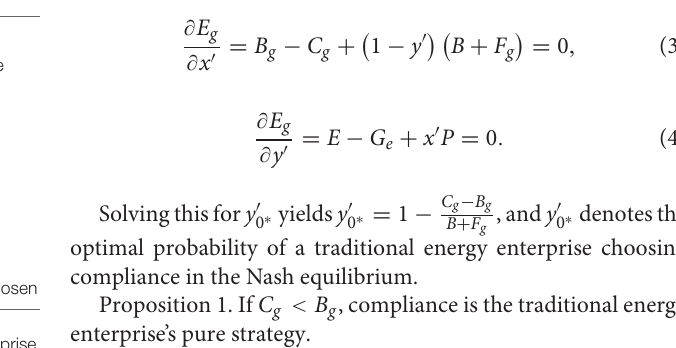
TABLE 1 | Notations and definitions used in this study. Parameters